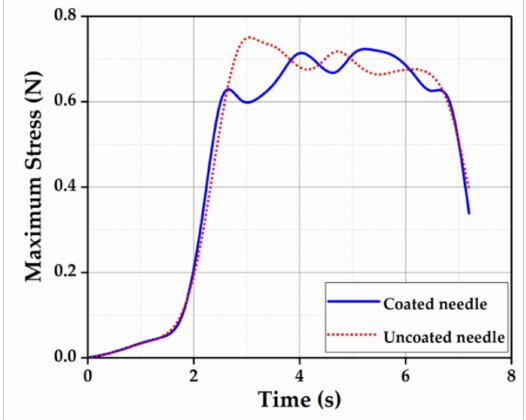
Figure 14. Maximum stress on the biological soft tissue.